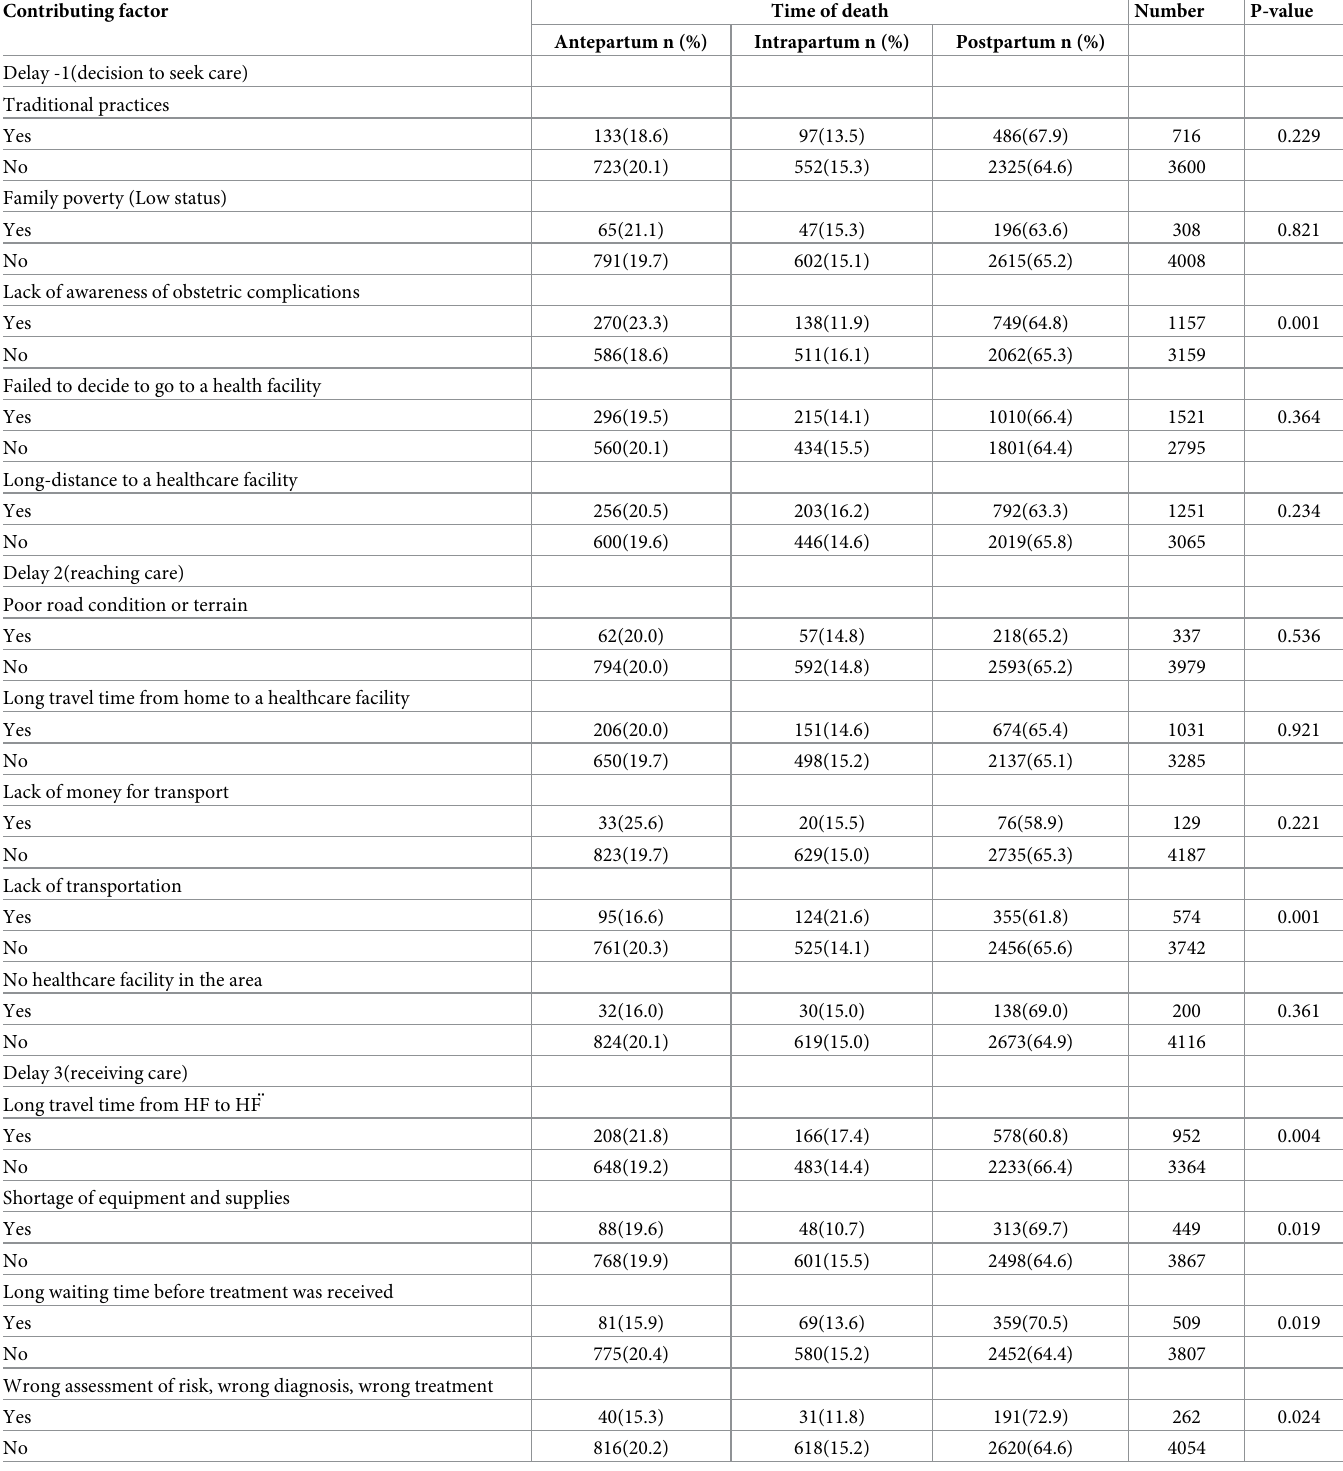
Table 4. Distribution of contributing causes of death by time of death among reviewed maternal death in Ethiopia,